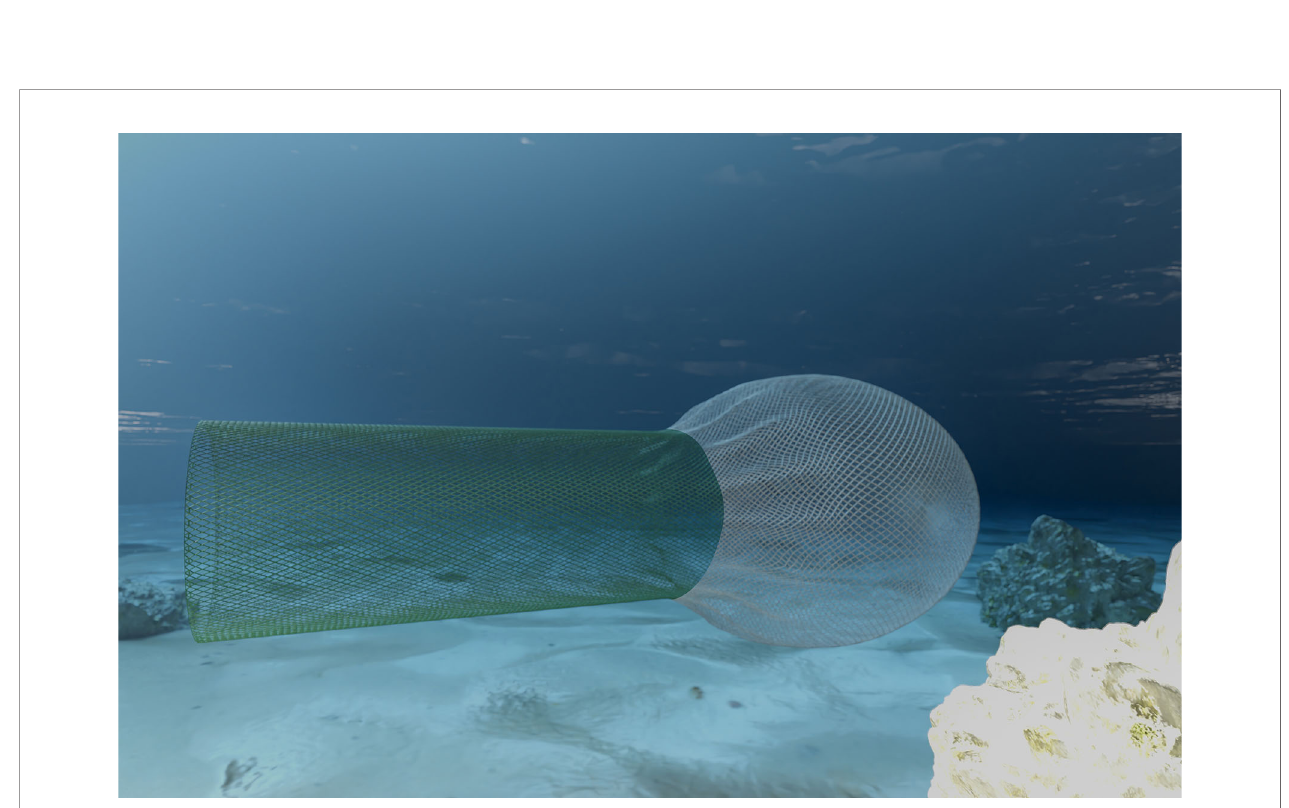
FIGURE 7 | Illustration of the hypothetical codend folding due to a reduction of the number of meshes in the extension piece